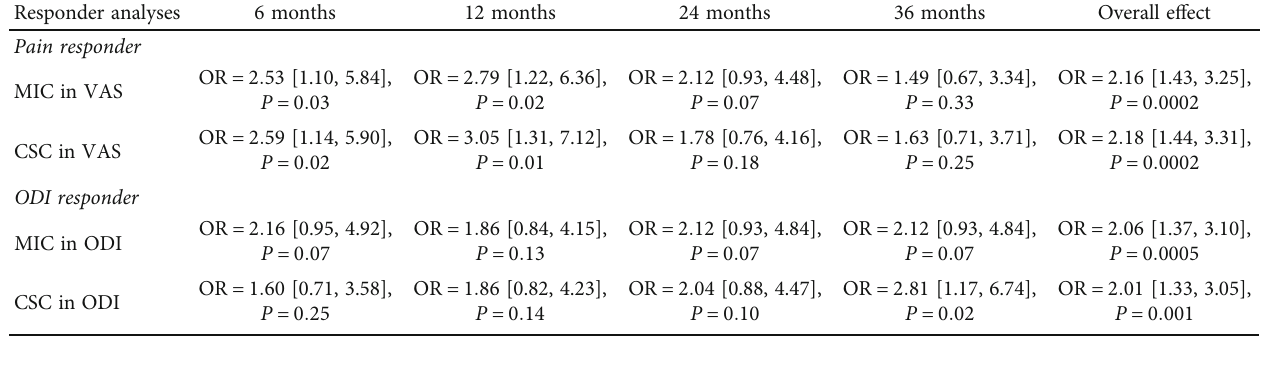
Table 2: Subgroup analysis.